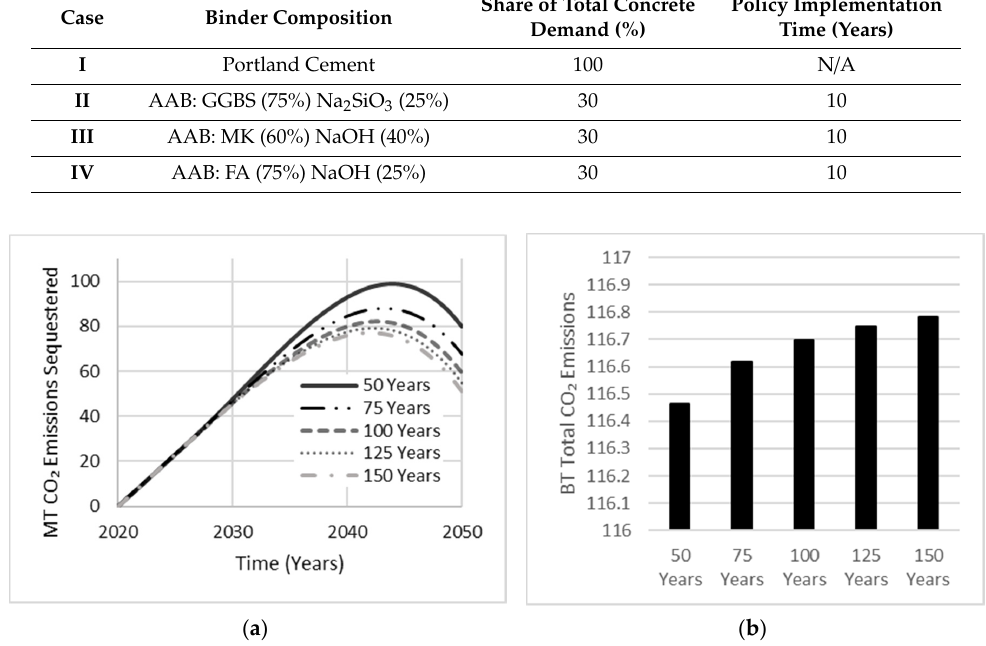
Figure 13. Sensitivity analysis exhibiting the effect of AAB service life on ( a ) total carbonation and ( b ) total CO ₂ emissions released.